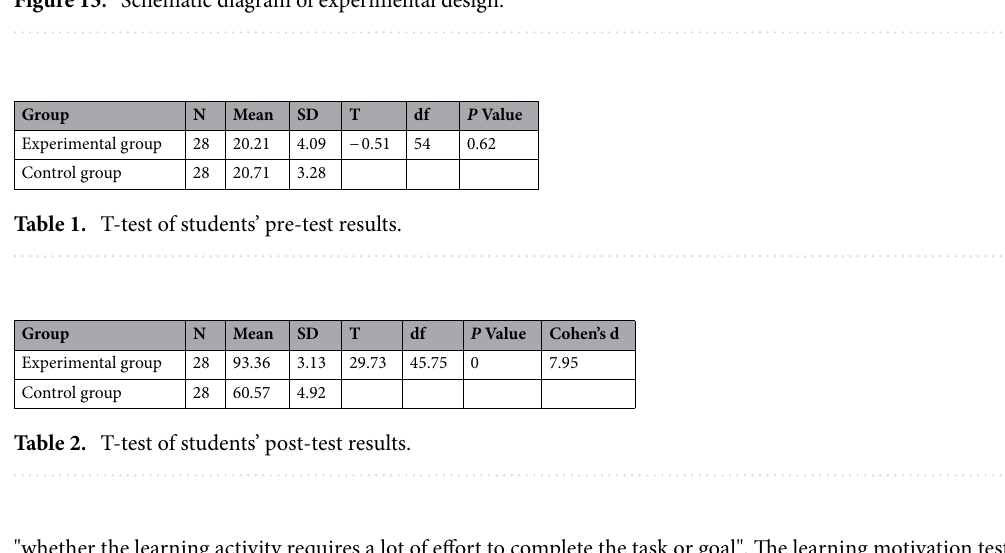
Figure 13. Schematic diagram of experimental design.